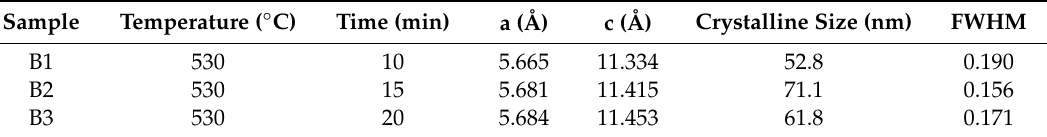
Figure 7. XRD spectra of CMZTSSe films annealed at 530 °C for different time ( a ) 10 min, ( b ) 15 min, ( c ) 20 min. Inset: Enlarged view of the corresponding (112) diffraction peaks of the CMZTSSe films annealed for different times. Table 4. The full width at half-maximum (FWHM), grain size, a-axis lattice constant (a), and c-axis lattice constant (c) for CMZTSSe films annealed for different times.